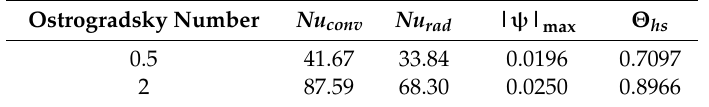
Table 5. Variations of different considered parameters for Ra = 10 9 , (cid:101) (cid:101) = 0.6, τ =